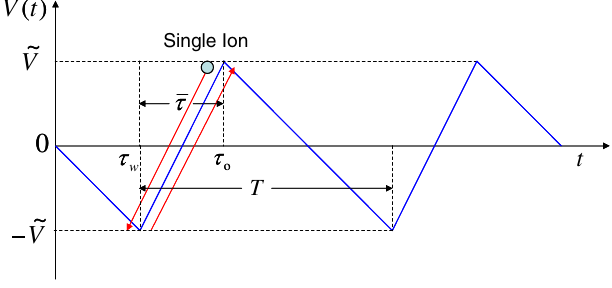
FIG. 1. (Color) Voltage waveform at the helix input z (cid:6) z